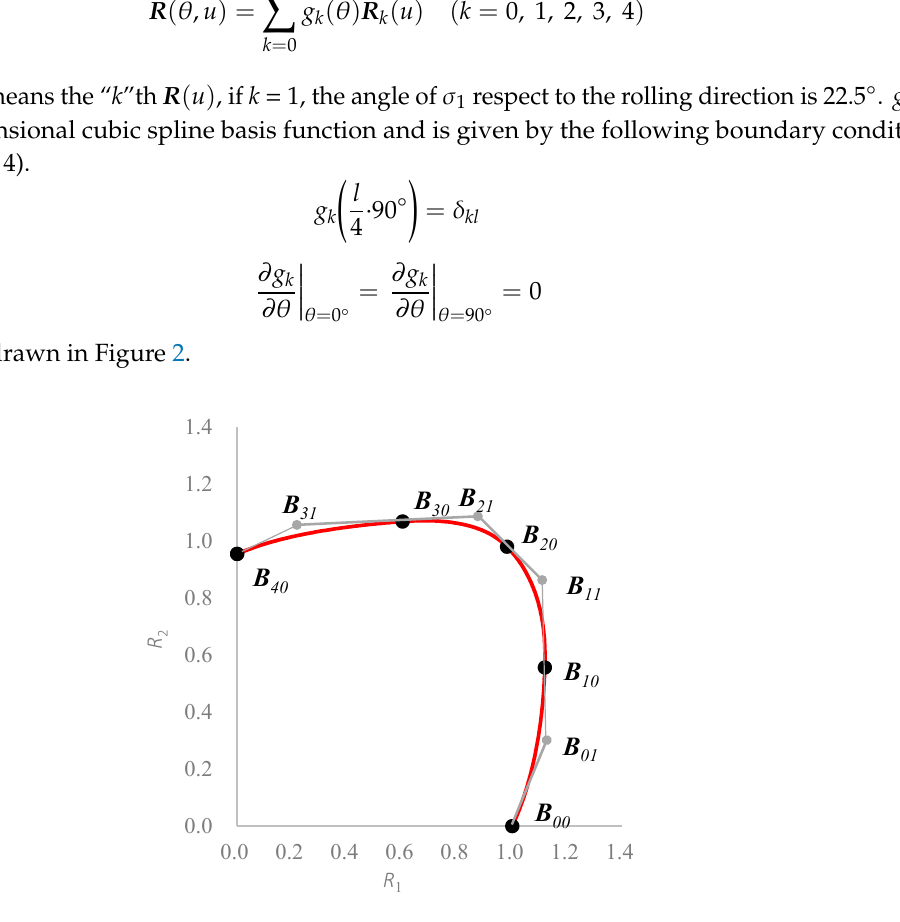
Figure 1. Spline yield function composed of Bézier curves.